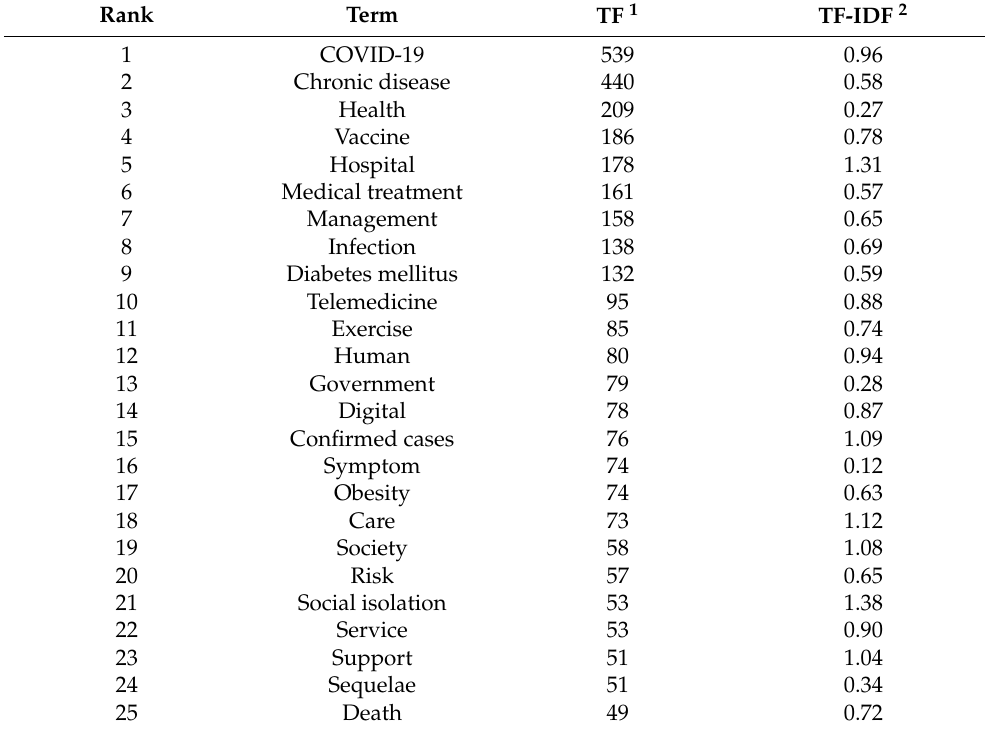
Table 1. Frequency To Rank of 25